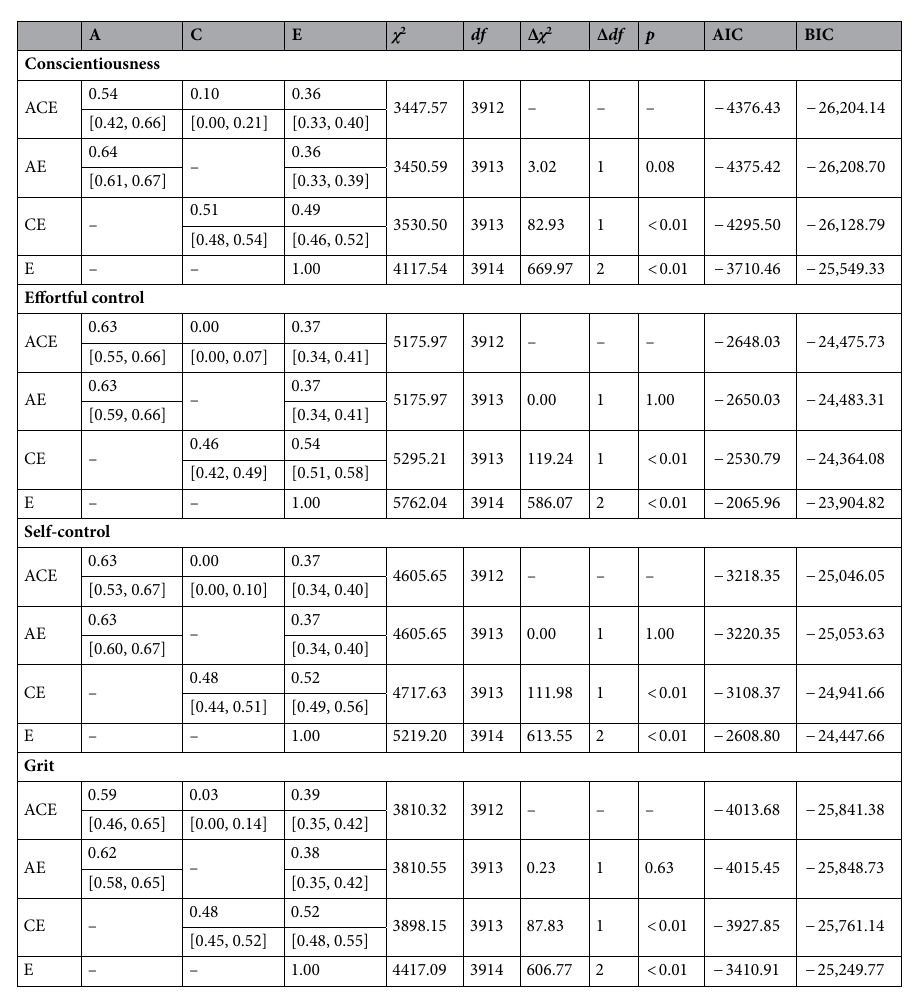
Table 2. Univariate model fitting results of the four conscientiousness variables with parametric estimates (and 95% confidence